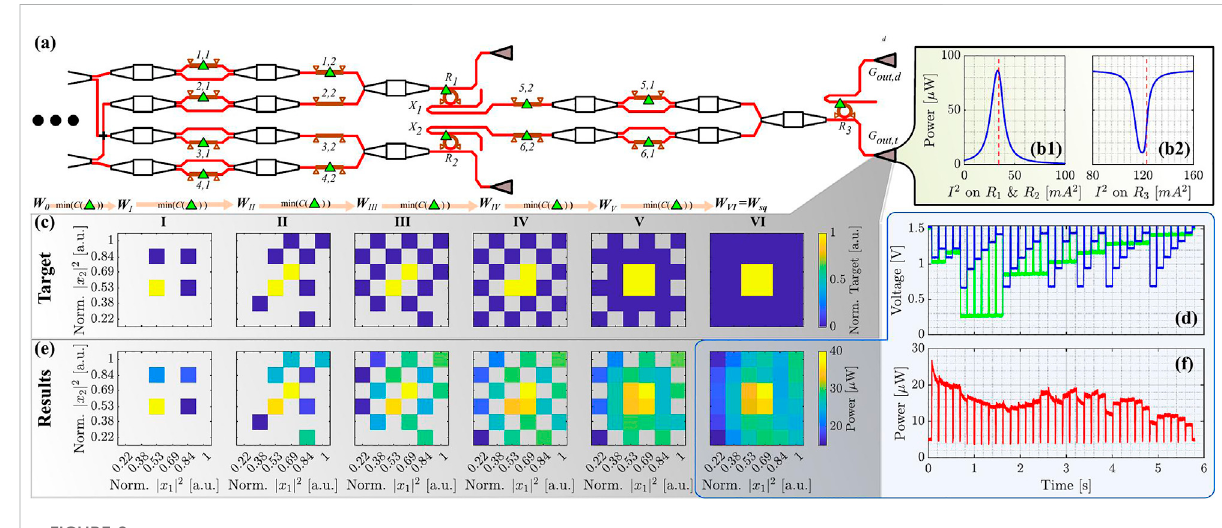
FIGURE 8 (A) sketchofthe fi rst andsecondhidden layers ofthefeed-forward network withtheusedmicroheaters evidenced bythegreen triangles.Each microheatersislabeledbytheindexoftheweightmatrix. (b1) Outputsignalintensity(collectedoutofthe G out ,t grating)asafunctionofthesquareof the currents of the microheaters R 1 and R 2 . The dashed red line highlights the initial working points of the microresonators. (b2) Output signal intensity as a function of the square of the current of the microheater R 3 . (C) Sequence of the different sub-tasks which lead to the fi nal target, i.e., the square shape. (D) Temporal sequence of the voltages applied to the microheaters of the input layer ( in 1,1 -blue line- and in 2,1 - green line) to form the domain set. (E) Experimental maps of the output response after the training for the different sub-tasks described by panel (C) . (F) Time sequence of the output signals for the co-domain of map VI in panel (E)